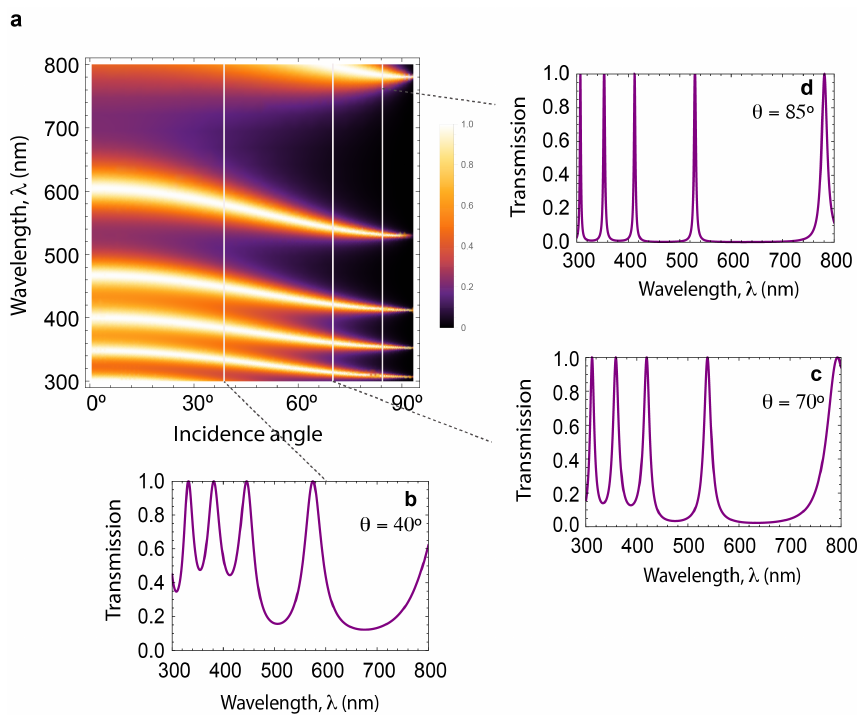
Figure 6. ( a ) Optical response of the ( BTO/Y 2 O 3 ) 2 /YBCO/ ( Y 2 O 3 /BTO ) 2 filter in the visible spectral region, for TE polarization in the whole range of incident angles at T = 80 K. The dark areas correspond to the high-reflectance ranges, and yellow regions indicate high transmission bands where radiation passes through the structure. Panels ( b – d ) display the measured transmittance at incident angles of 40 ◦ , 70 ◦ and 85 ◦ (marked by the white vertical lines in ( a ),